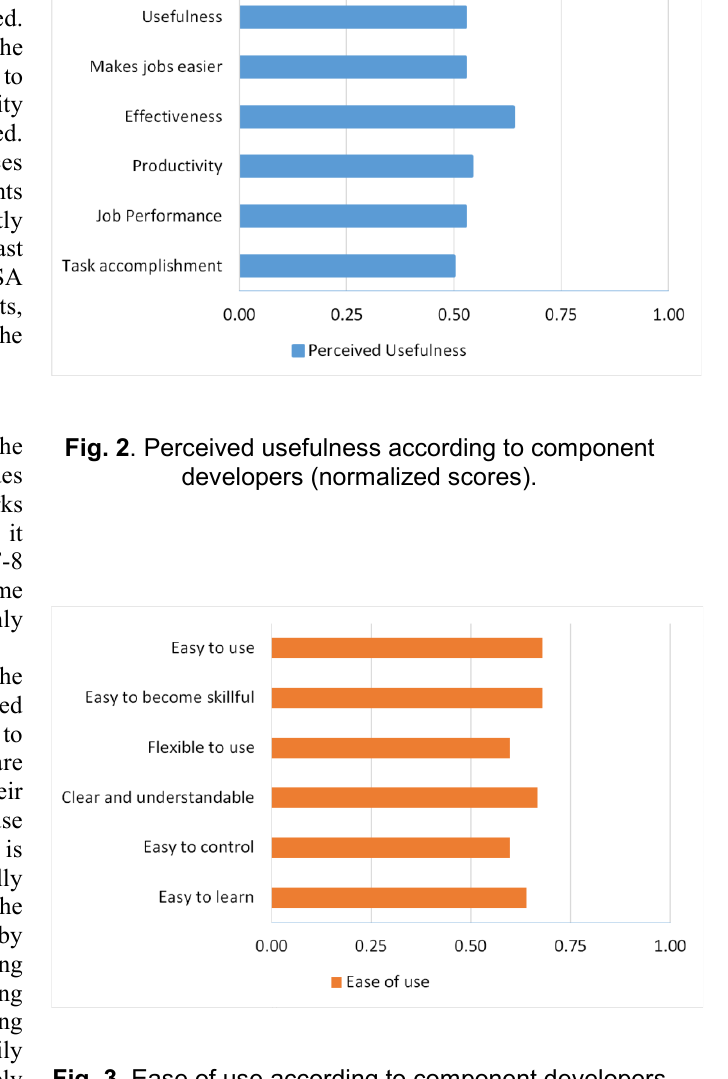
Fig. 3. Ease of use according to component developers (normalized